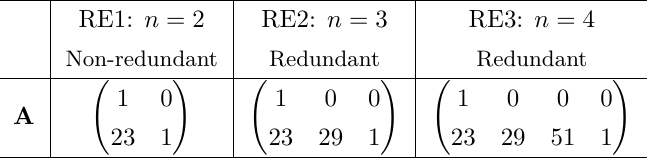
Table 7: Various choices of A over F ( k + m ) × n